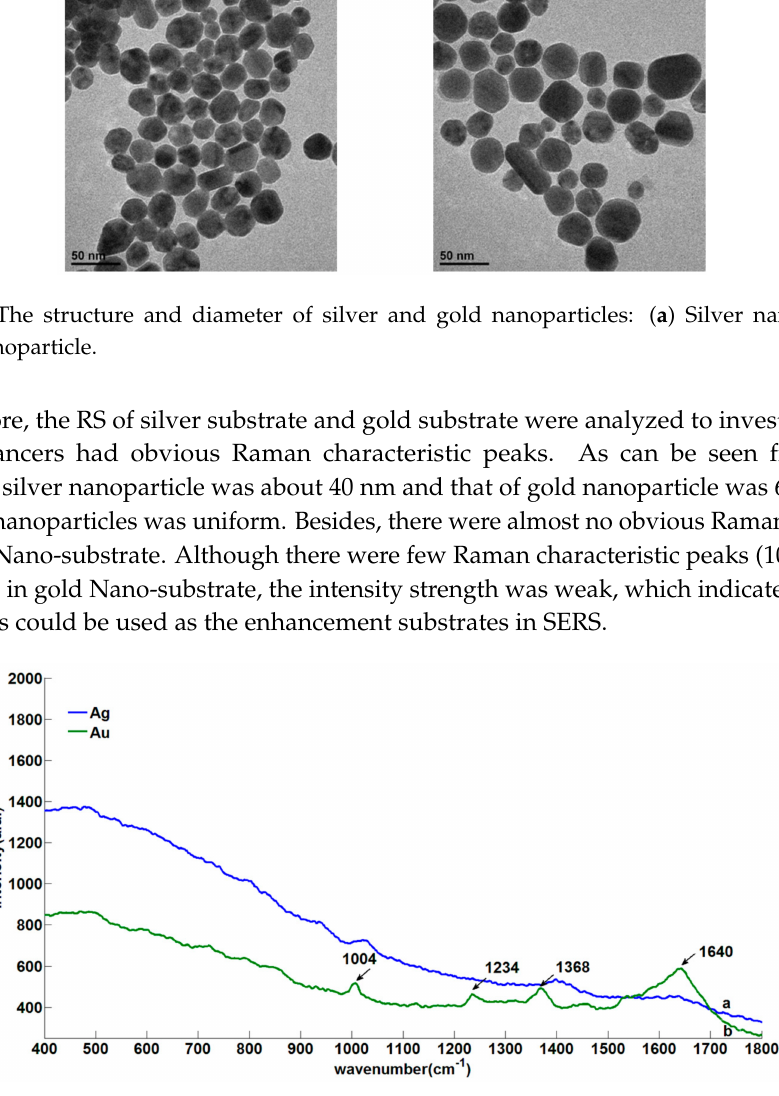
Figure 3. The RS of silver and gold substrate: ( a ) Silver Nano-substrate; ( b ) gold